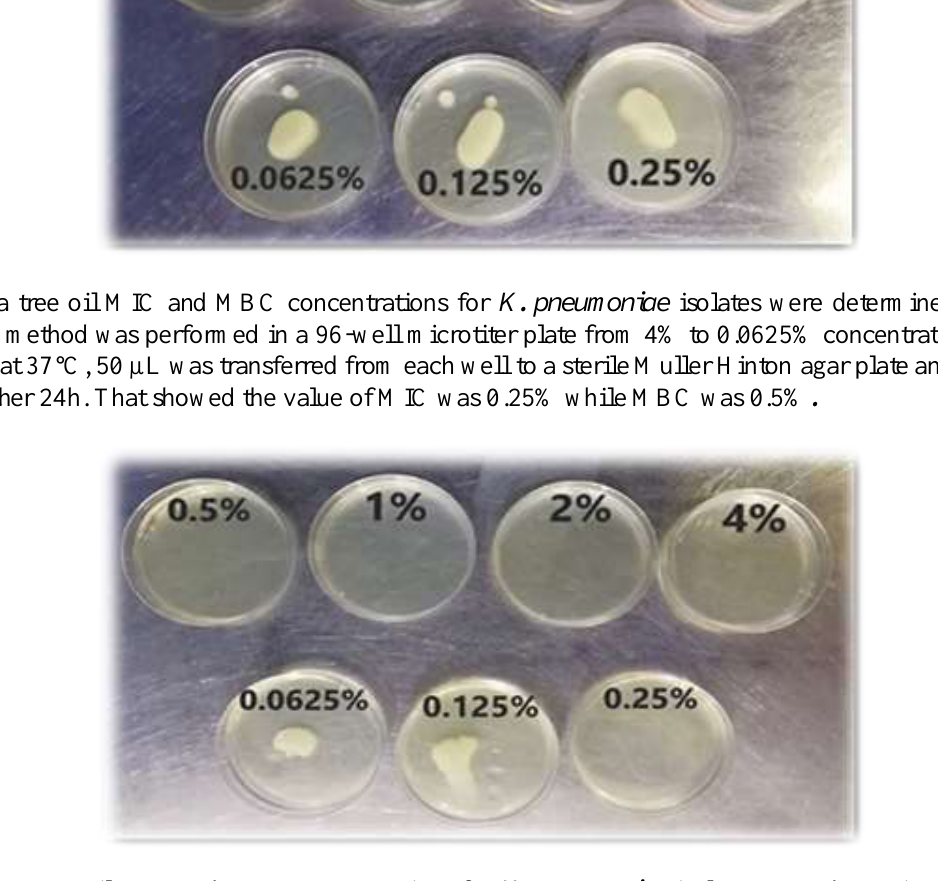
Figure 3: Cinnamon oil MIC and MBC concentrations for K. pneumoniae isolates were determined via the broth dilution method was performed on a 96-well microtiter plate from 4% to 0.0625% concentration. After 24h of incubation at 37°C, 50 µL was transferred from each well to a sterile Muller Hinton agar plate and incubated at 37°C for another 24h. That showed the value of MIC was 0.125% while MBC was 0.25% . Andrade et al. reported that the MIC of TTO ≤0.5% (v/v) for K. pneumoniae and other different bacteria